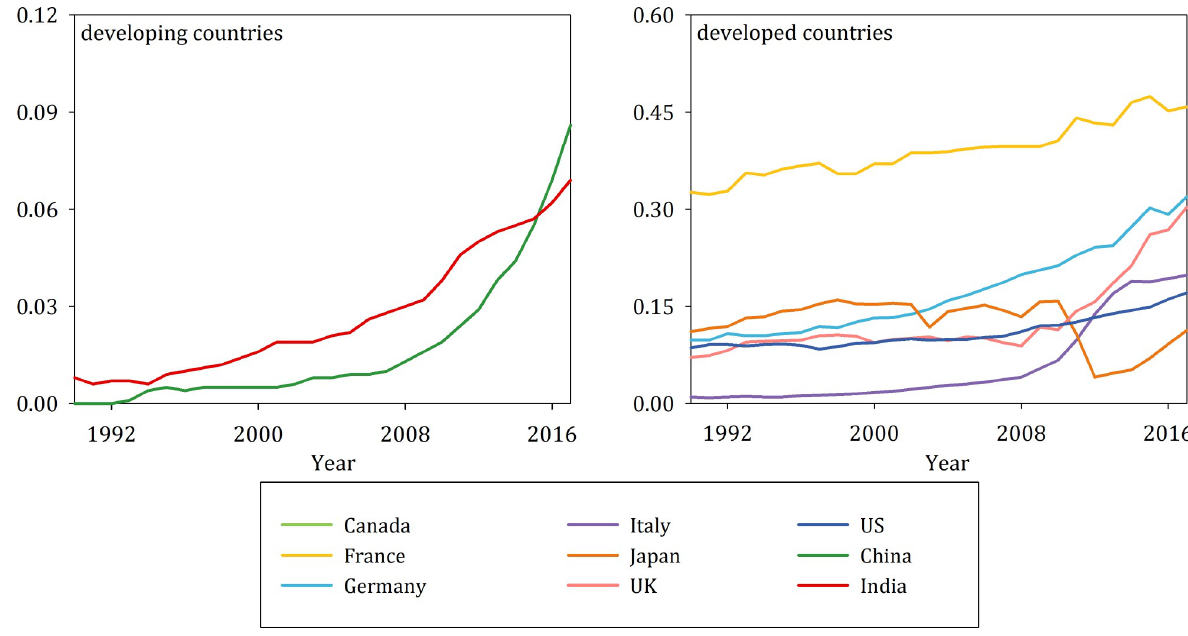
Fig 8. Clean energy as a proportion of primary